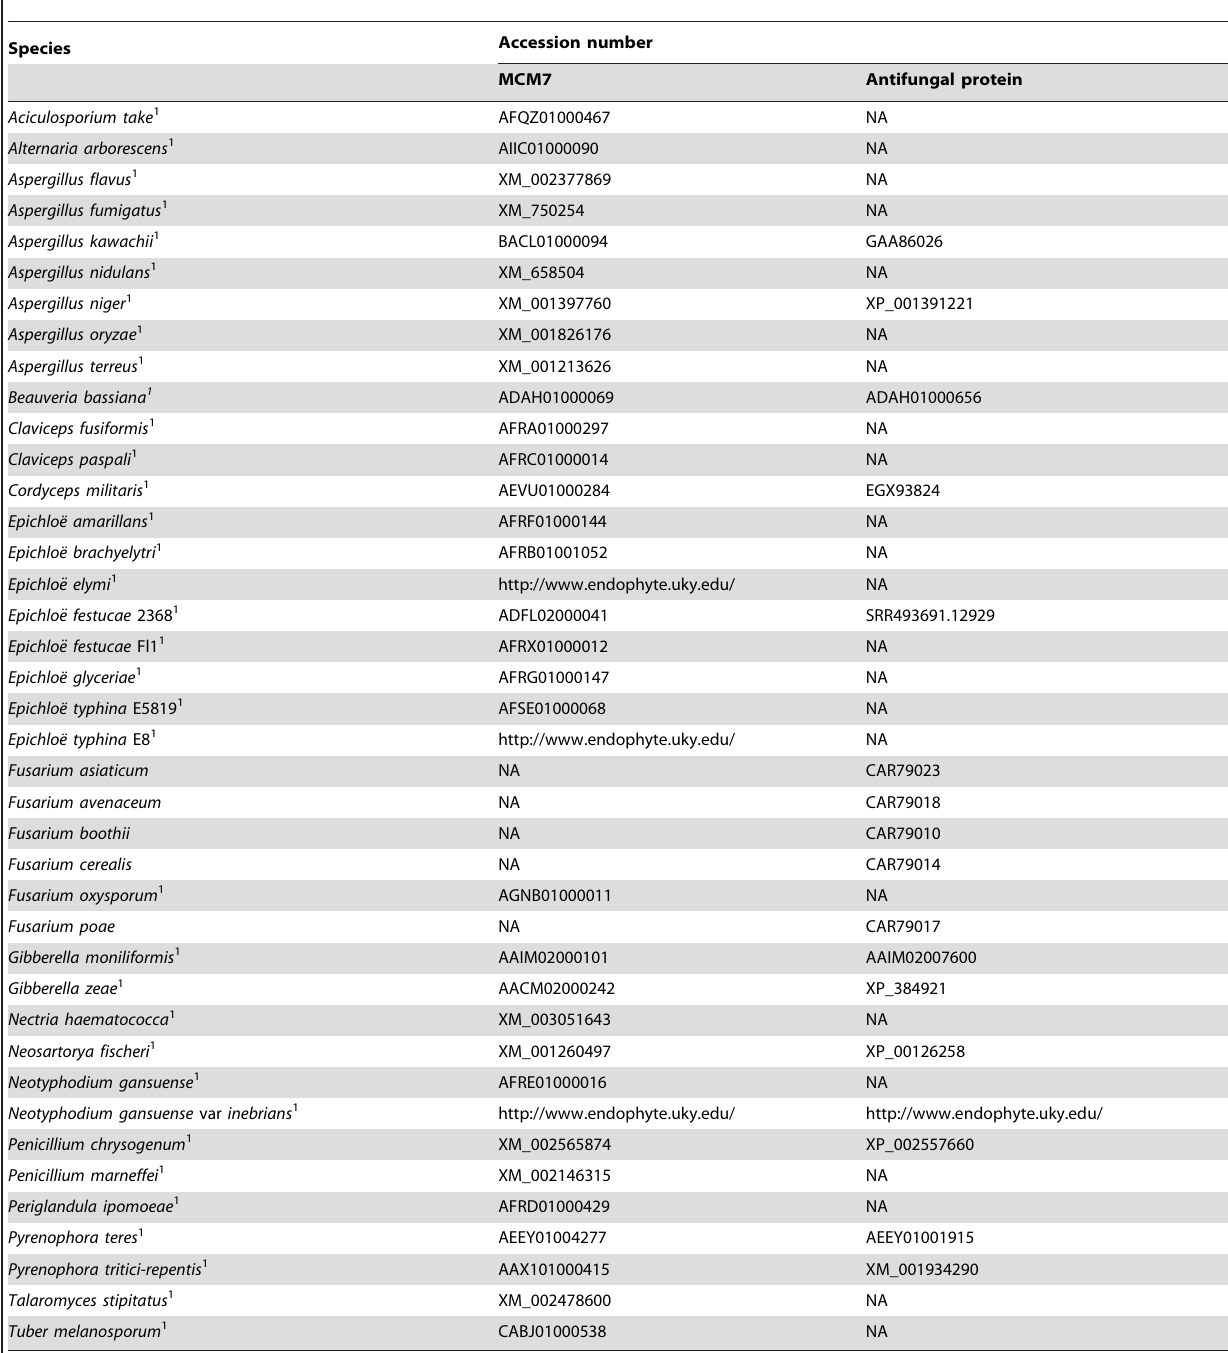
Table 5. Accession numbers of the MCM7 and antifungal protein sequences used in the phylogenetic analyses presented in Fig. 2.